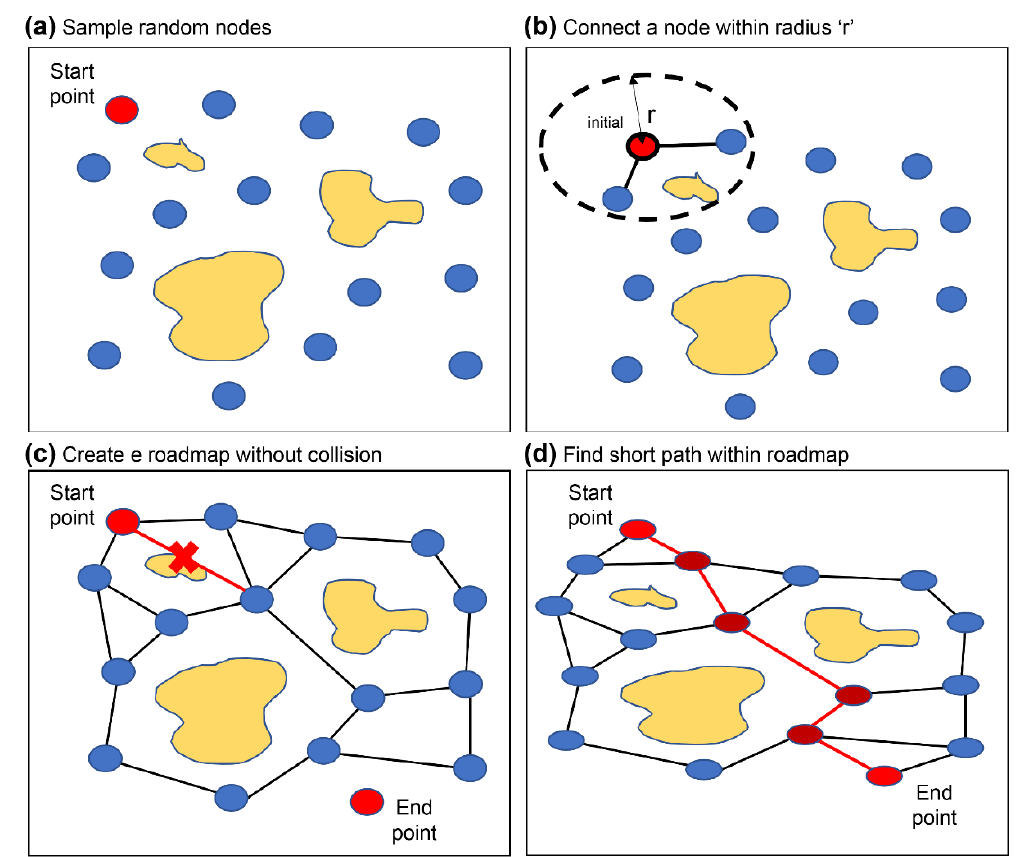
Figure 3. The probabilistic road map (PRM) algorithm’s search process: (a). Sample random nodes, ( b ) Connect a node within radius ‘ (cid:1870) ’, ( c ) Create e roadmap without collision, and ( d ) Find short ( b ) Connect a node within radius ‘ r ’, ( c ) Create e roadmap without collision, and ( d ) Find short path path within roadmap. within